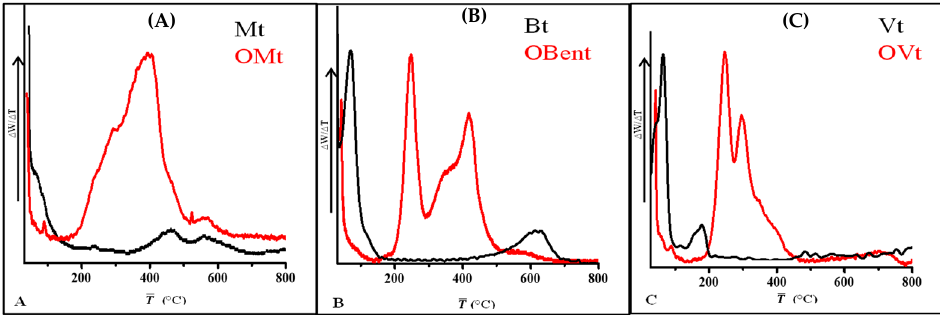
Figure 6. Thermal analysis (DTG curve) of ( A ) Mt, OMt, ( B ) Bent, OBent and ( C ) Vt, OVt.